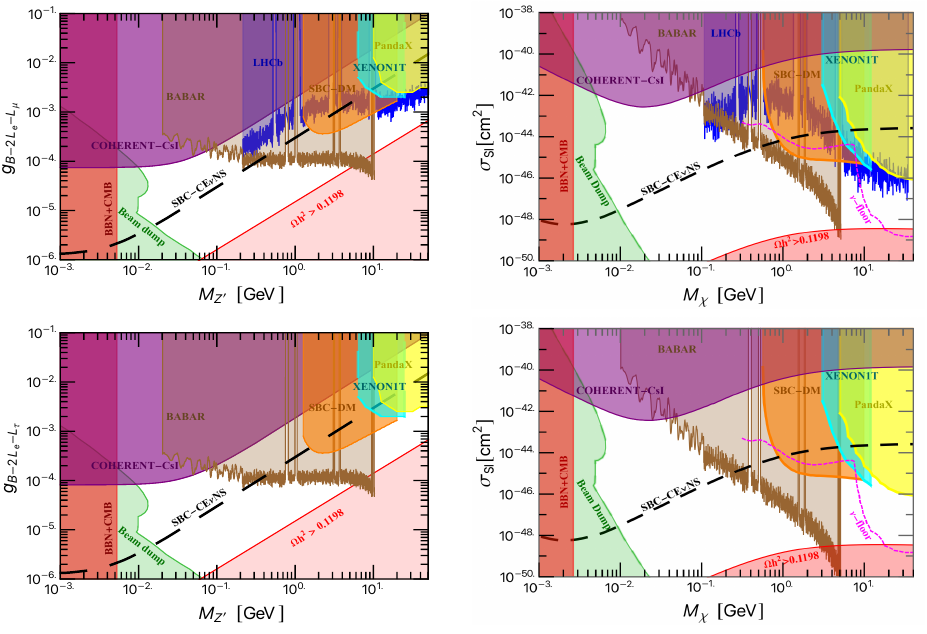
Figure 4 . Same as figure 2 but for the MIII U(1) 0 models as given by table